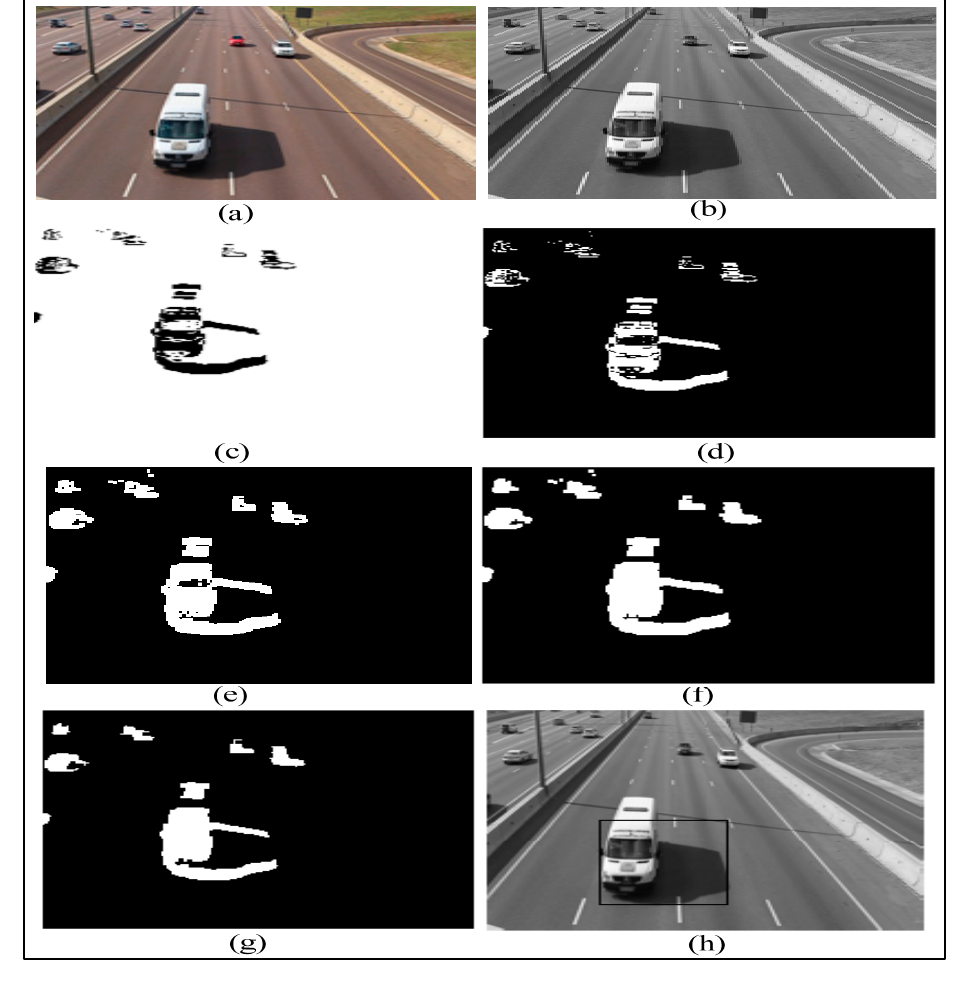
Figure 15. Distance measurement techniques: ( a ) Euclidean distance; ( b ) Manhattan distance; ( c ) Canberra distance.